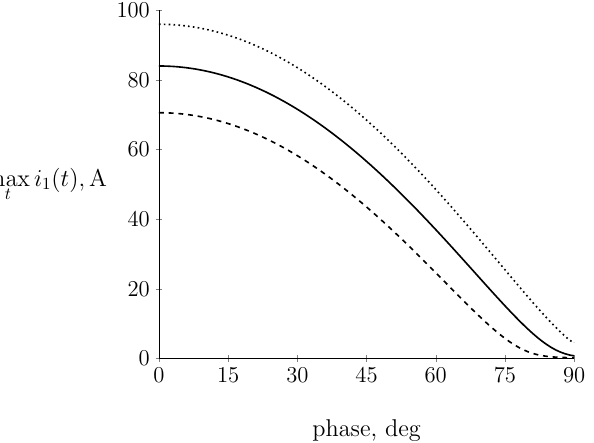
i 1 ( t ) (simulated values) on the primary side of | |